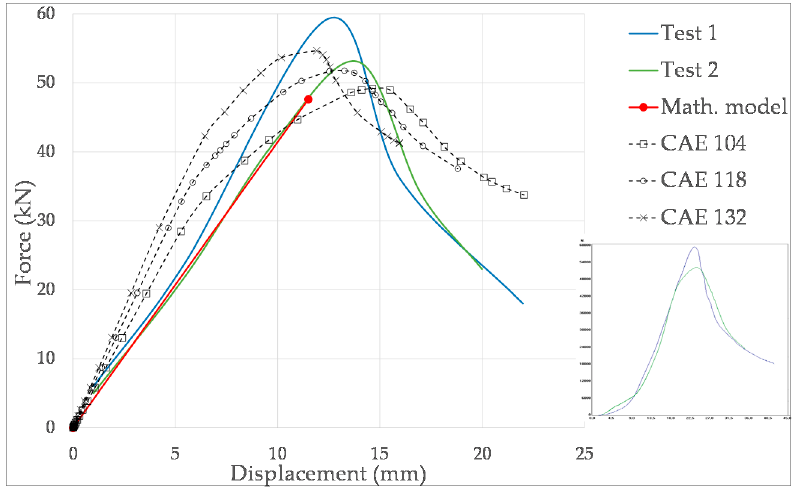
Figure 12. Comparison of force-displacement curves among CAE, mathematical and experimental results for the O-04 item. Table 6. Results of the BCT force and δ vertical displacement for experimental tests and for the CAE and mathematical models of the O-04.